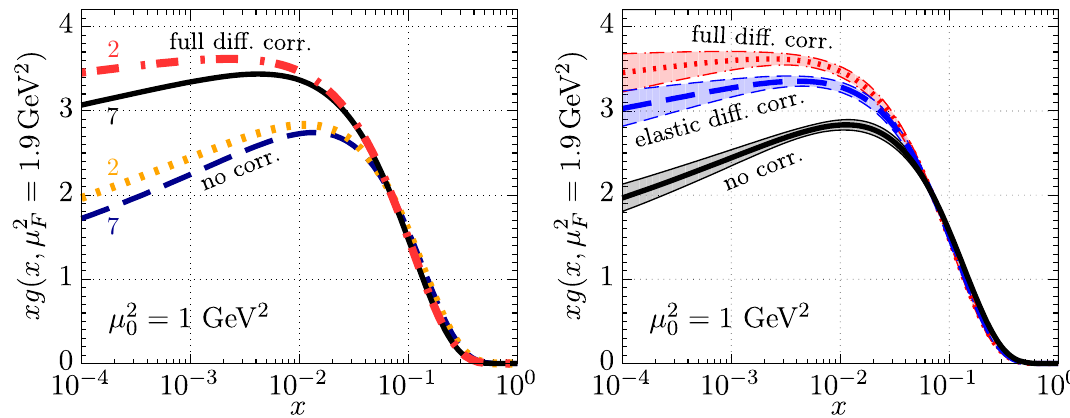
Fig. 5 Left: Gluon distributions fitted including power corrections coming from the low scale behaviour of running α s coupling ( μ 0 = 1 GeV). The ‘linear’ gluons become almost flat in the small x region. Right: Gluon distributions with error bars using data with Q 2 > 2GeV 2 and μ 0 = 1GeV